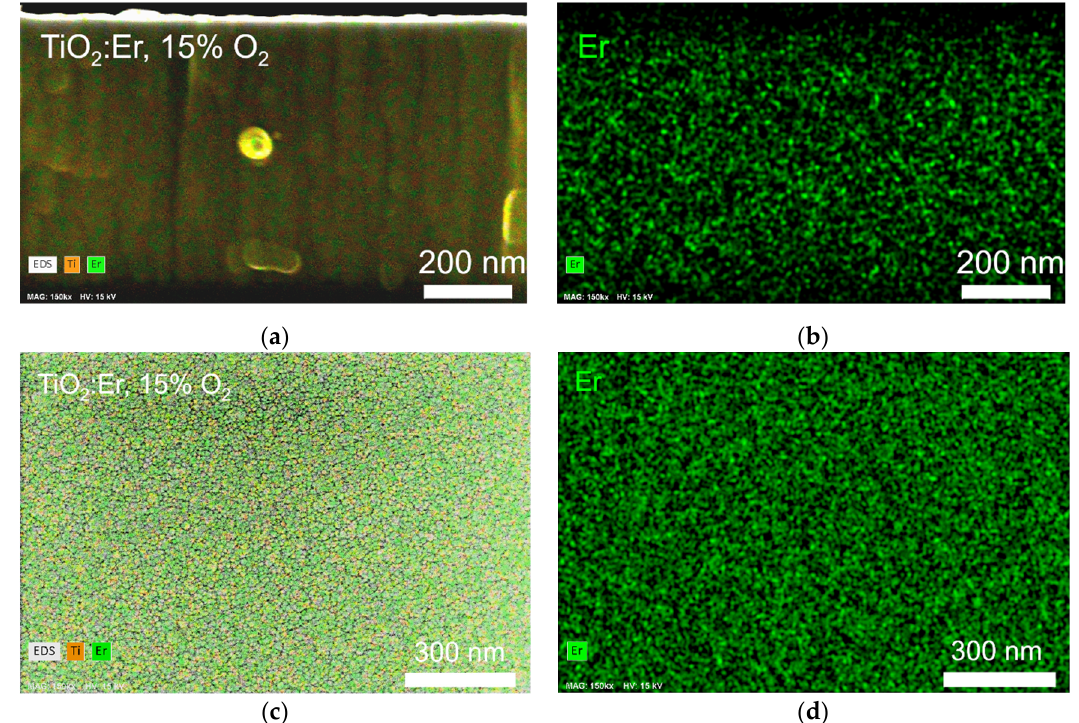
Figure 5. EDS elemental mapping: ( a , b ) cross section and ( c , d ) surface of TiO 2 :Er deposited at 15% O 2 .